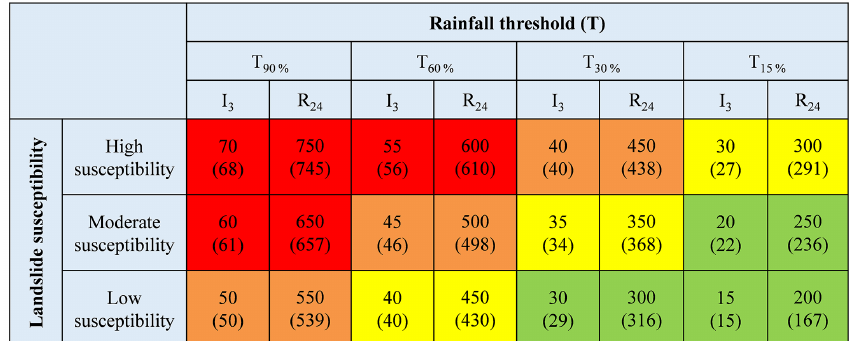
Table 7. Rainfall thresholds for southern Taiwan. The values were calculated as 90, 60, 30 and 15% of the original threshold. After that, I 3 was rounded to the nearest 5mmh − 1 and R 24 was rounded to the nearest 50mm for operational purpose (e.g., evacuation). The original values are shown in parentheses.